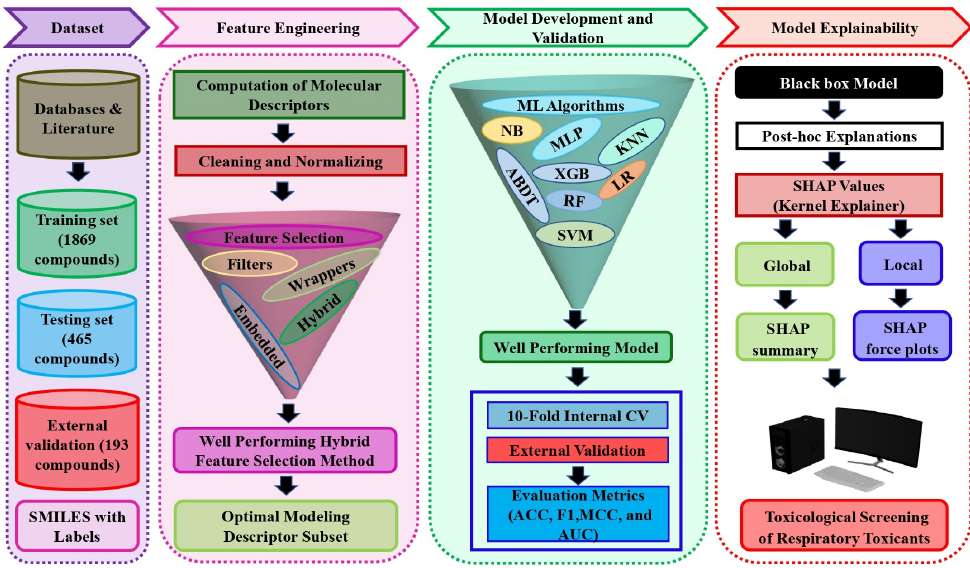
Figure 1. The schematic workflow of the proposed explainable respiratory toxicity prediction model.